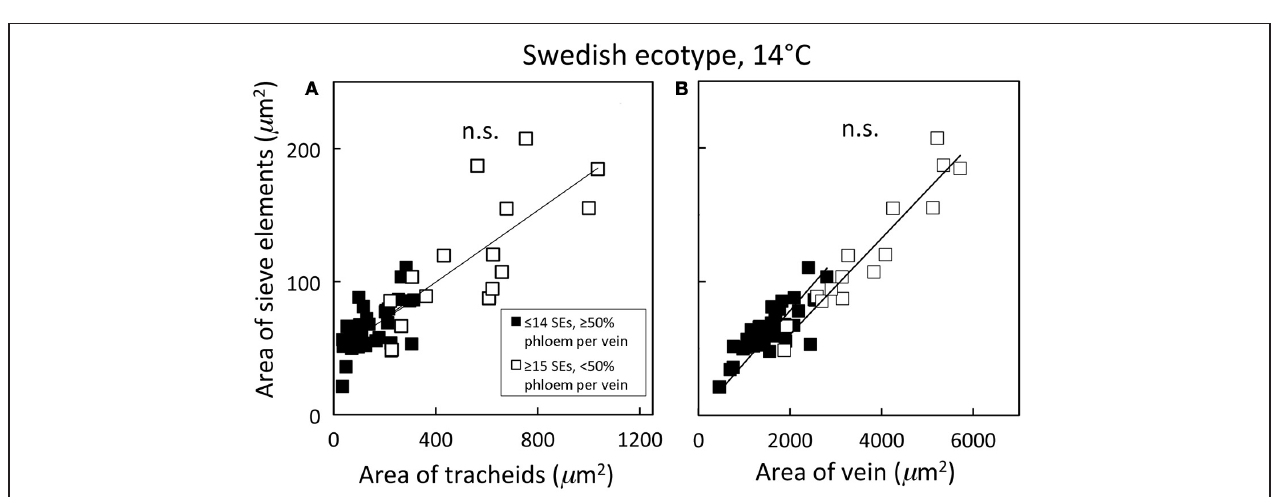
FIGURE 5 | Relationship between the cross-sectional sieve element area of a vein and (A) the cross-sectional tracheid area of a vein and (B) the cross-sectional area of the entire vein for individual second-, third-, and fourth-order veins from the Swedish ecotype grown at 14 ◦ C under 400 µ mol photons m − 2 s − 1 . Individual veins ( n = 52) were segregated by sieve element (SE) number and ratio of phloem area/vein area into veins containing ≤ 14 SEs and phloem area/vein area ≥ 0.5 (black squares; putative minor loading veins) or ≥ 15 SEs and phloem area/vein area < 0.5 (open